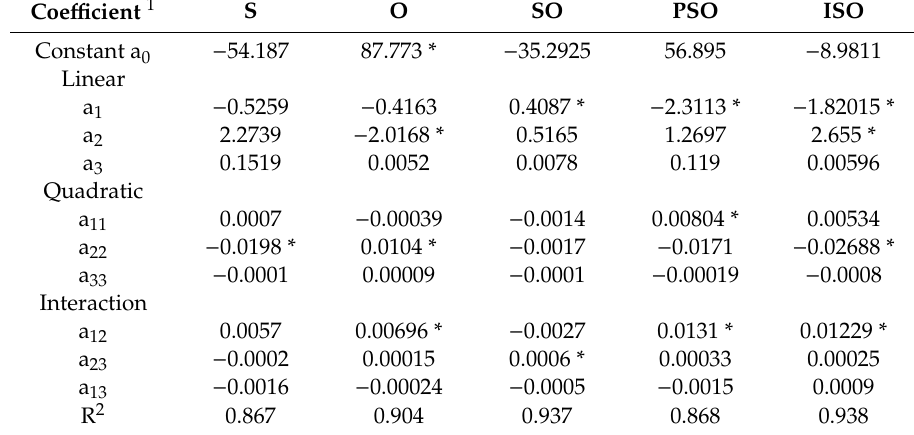
Table 3. Texture ( Firmness, F max ) coe ffi cients for tomato pre-treated with di ff erent osmotic solutions, (Equation (4)), based on experimental data of the design shown in Table